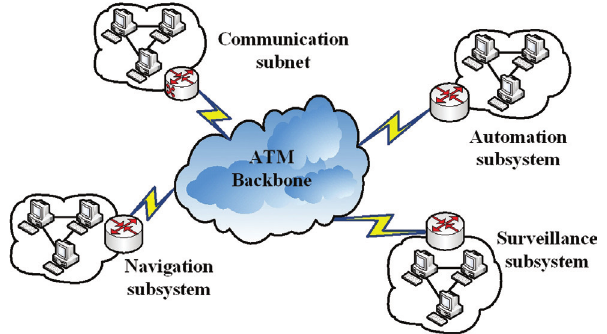
Figure 1. ATM System